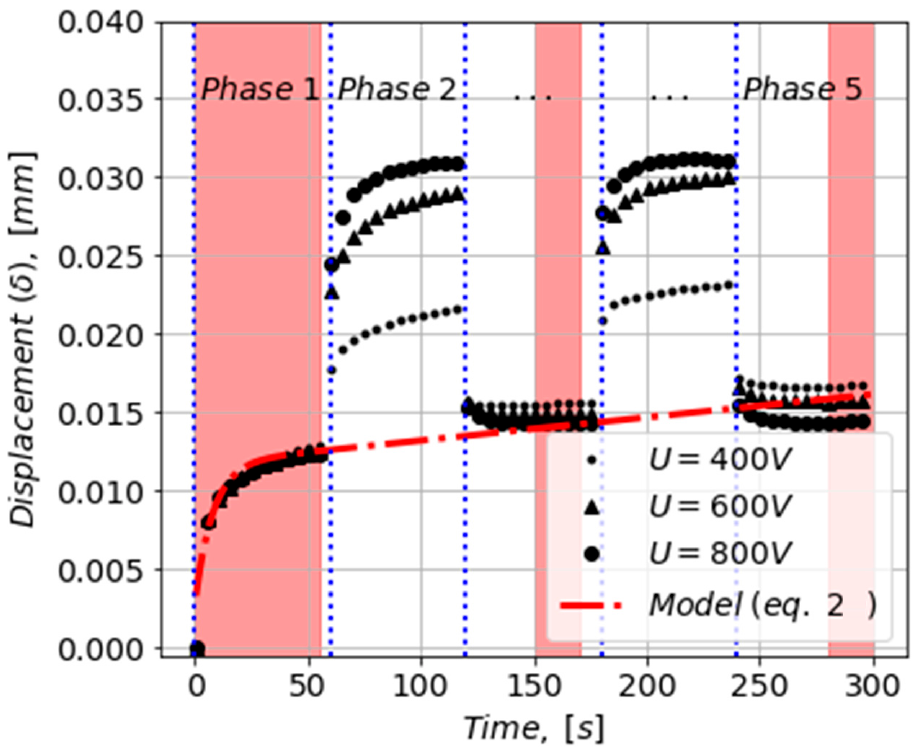
Figure 5. Data collected for F m = 3 N and for three magnitudes of U.